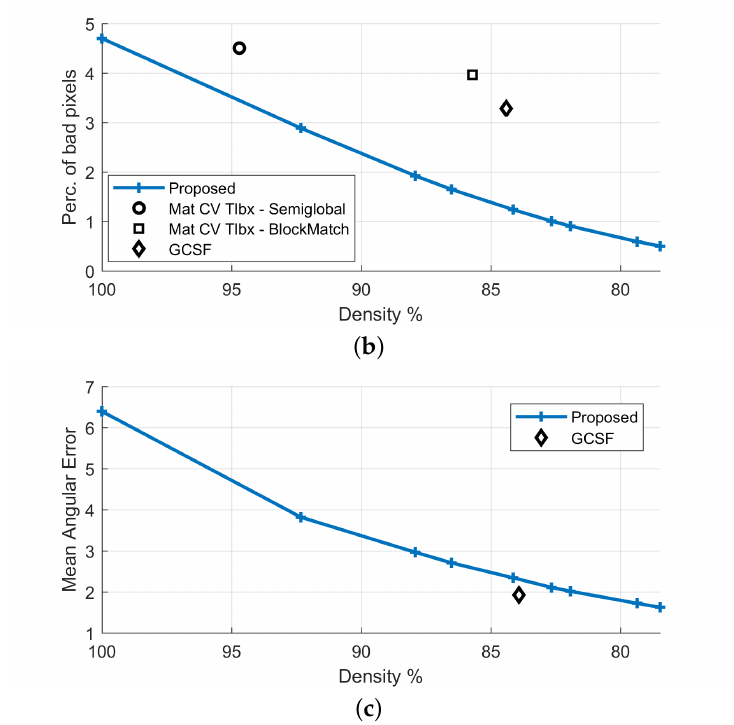
Figure 8. Artificial “Futuristic White-Tower” sequence: comparative results ( a , b ) with respect to disparity estimation and ( c ) with respect to flow estimation.